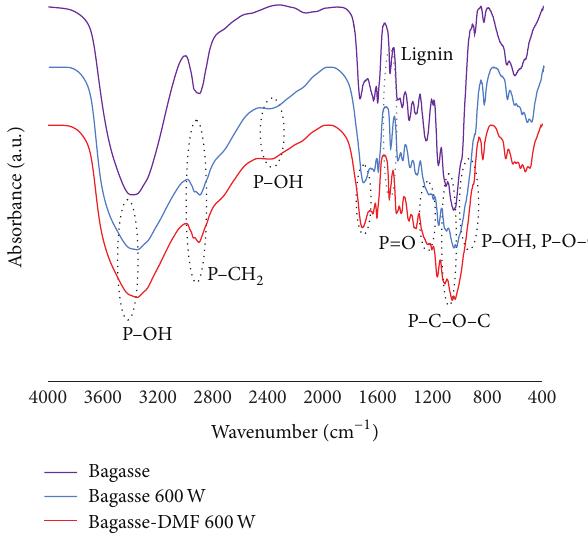
Figure 5: IR spectra of unmodified bagasse (Bagasse), modified bagasse (Bagasse 600 W), and Bagasse-DMF 600 W.